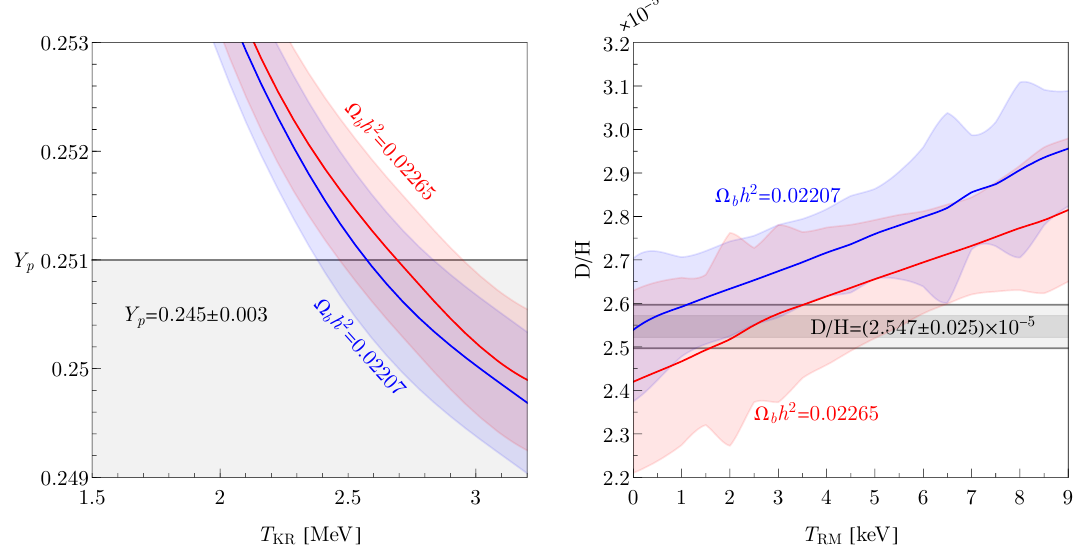
Figure 2 . Primordial helium (left panel) and deuterium (right panel) abundances as a function of T KR and T RM , respectively. The gray bands show the experimental